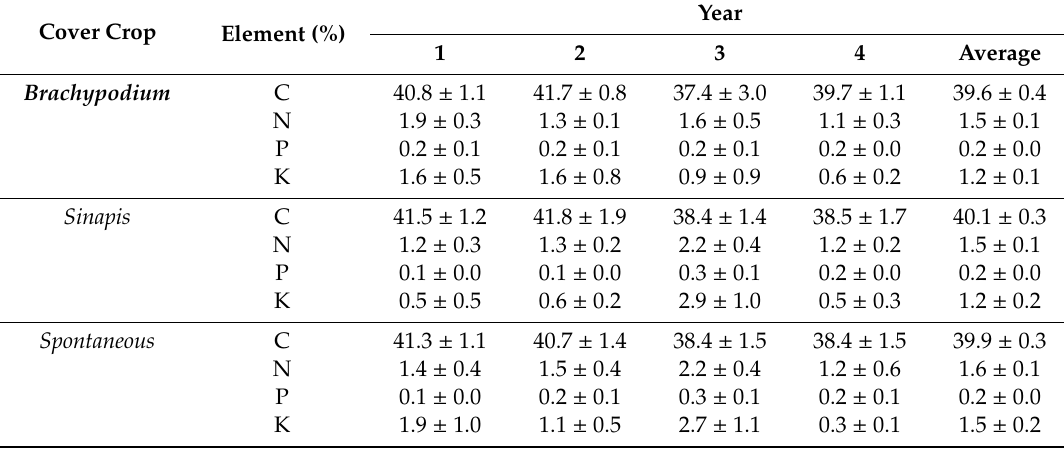
Table 4. Concentrations of C, N, P and K in the aboveground residues at the beginning of each decomposition